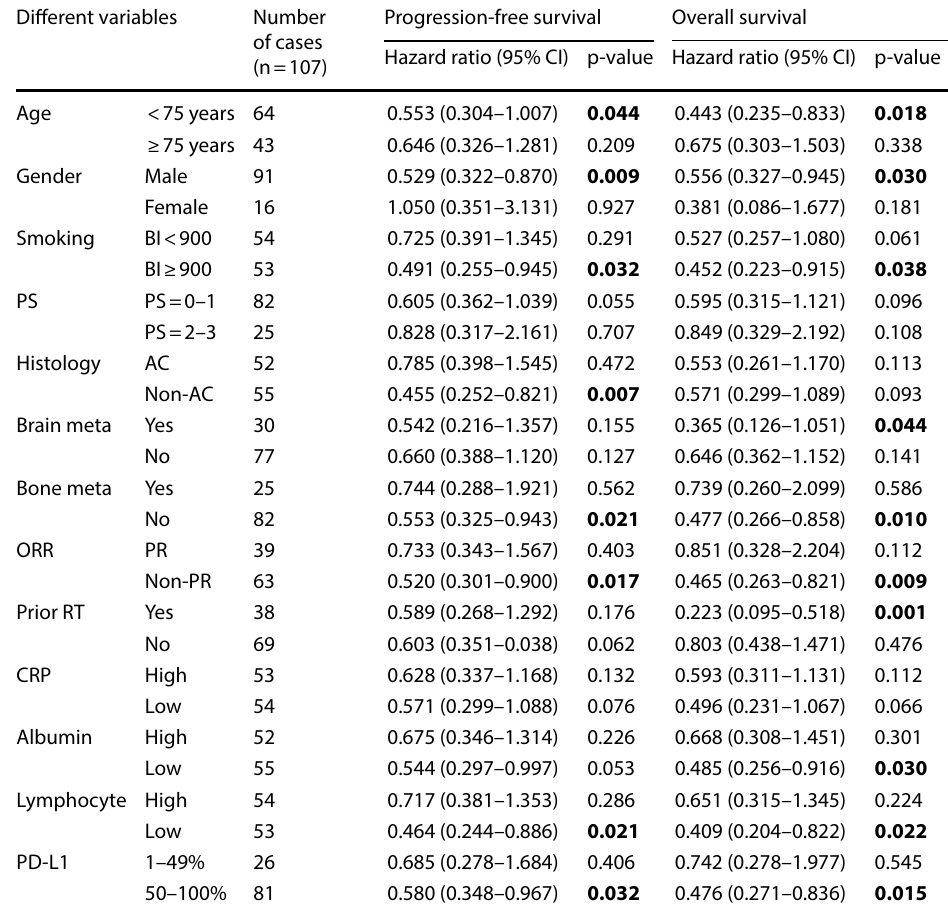
Table 3 Survival analysis of subgroups according to stromal CD4